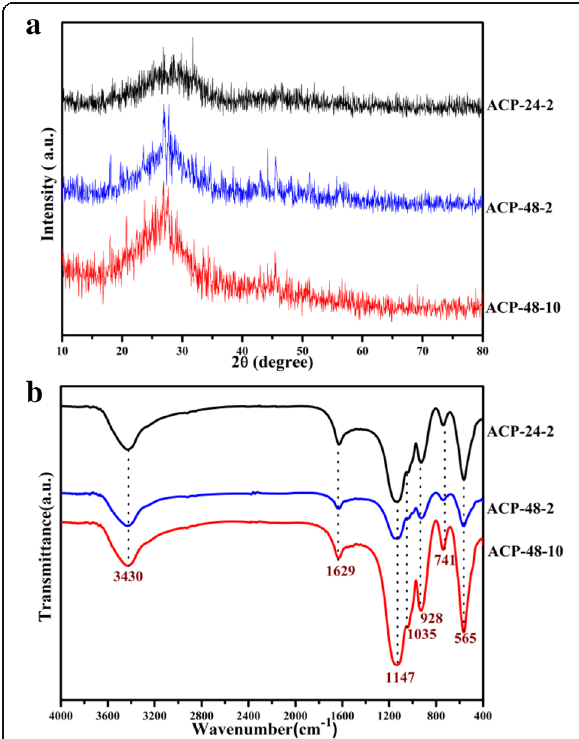
Fig. 1 XRD patterns ( a ) and FT-IR spectra ( b ) of the ACP nanospheres obtained under different